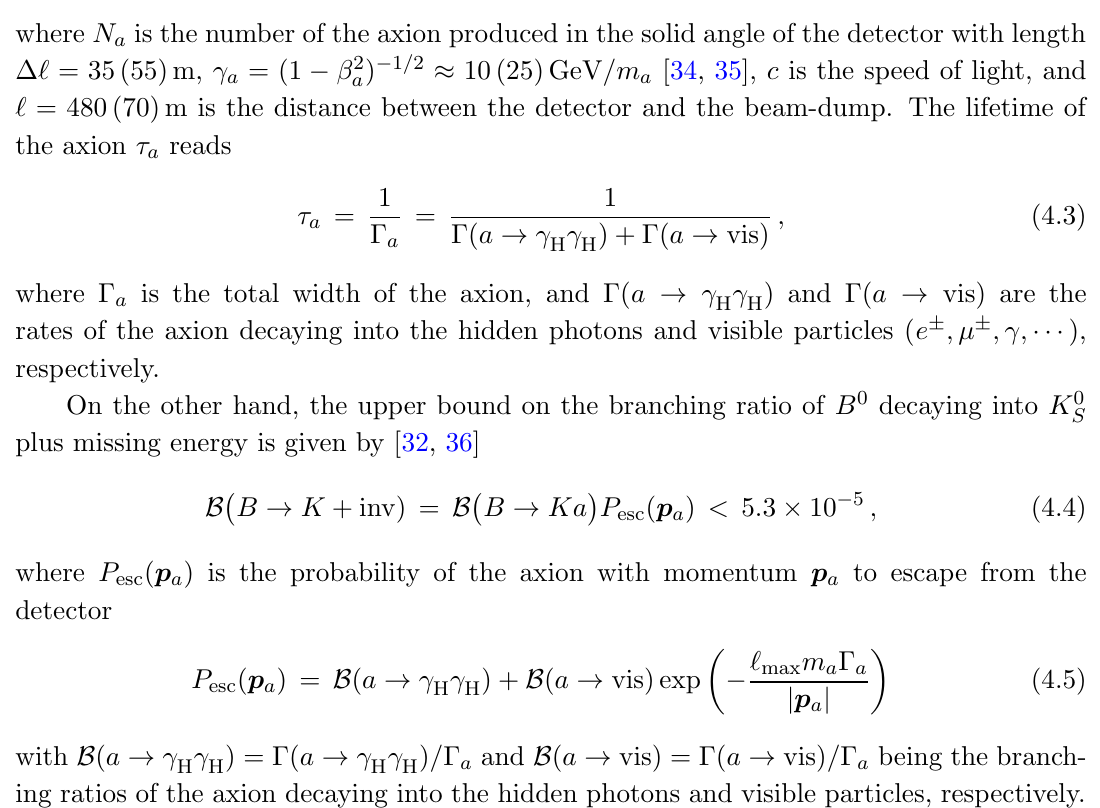
above the color